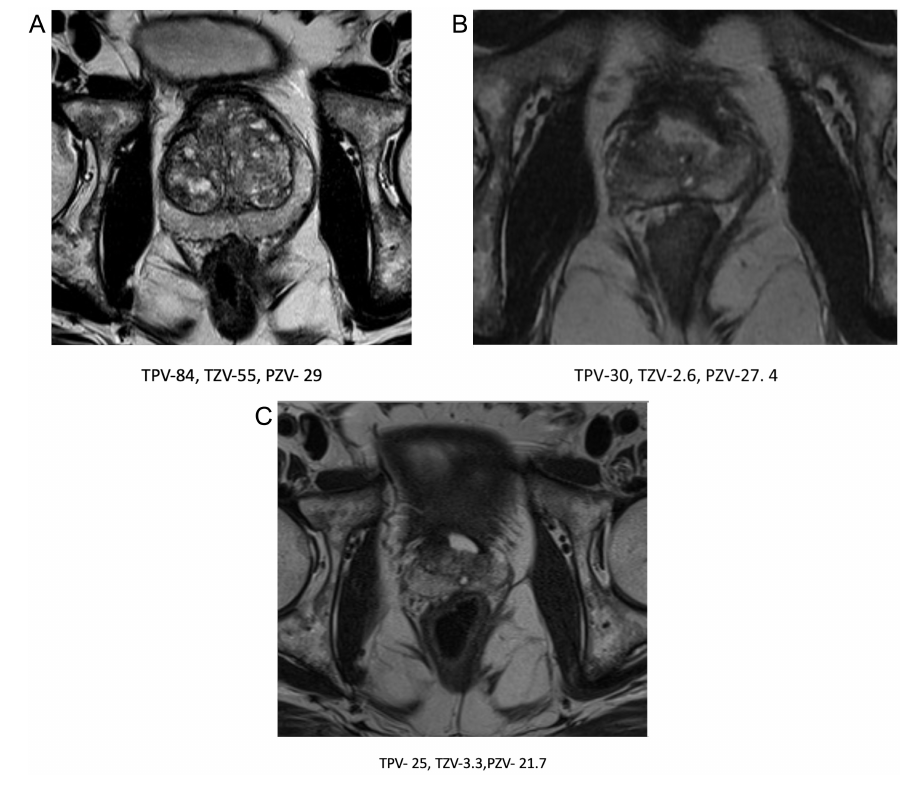
Figure 2. a-c. T2 weighted axial MRI images before and 6- week and 3 year after TURP procedure (volume in cc).